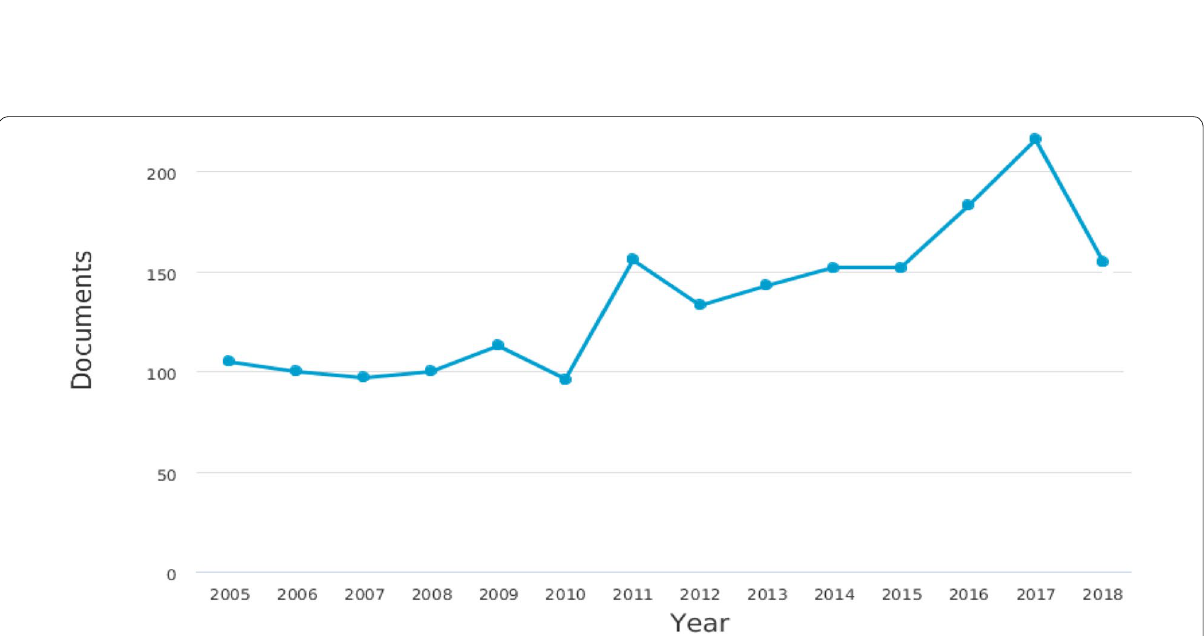
Fig. 3 Trends of forest ecosystem services study from 2005 to 2018 using Scopus database. This figure exclusively explains the trends of forest ecosystem services since 2005 on wards using Scopus as the main data source. It showed that the number of publication is increasing in positive ways up to 2017. However, the last year (2018) had the lower number of publication and it might be linked with the time demands to register the published articles from various journal types in Scopus data